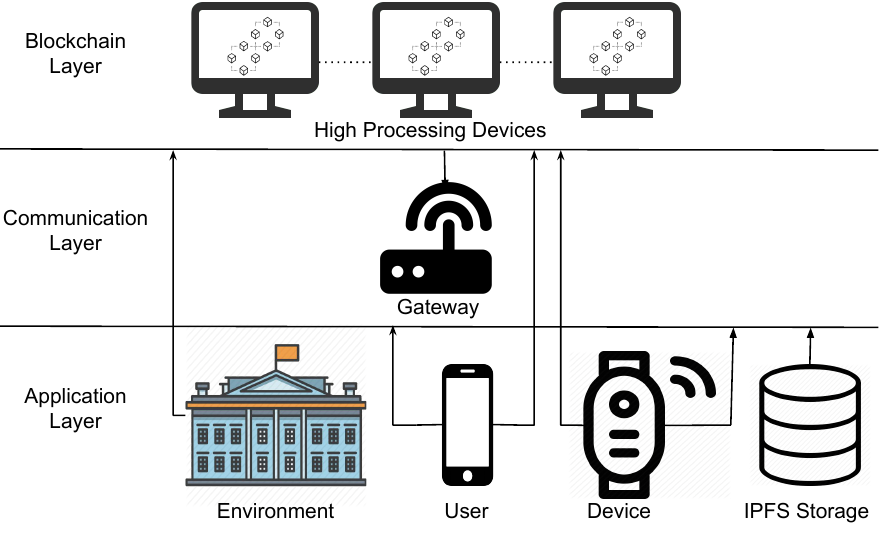
Figure 5. PRICHAIN